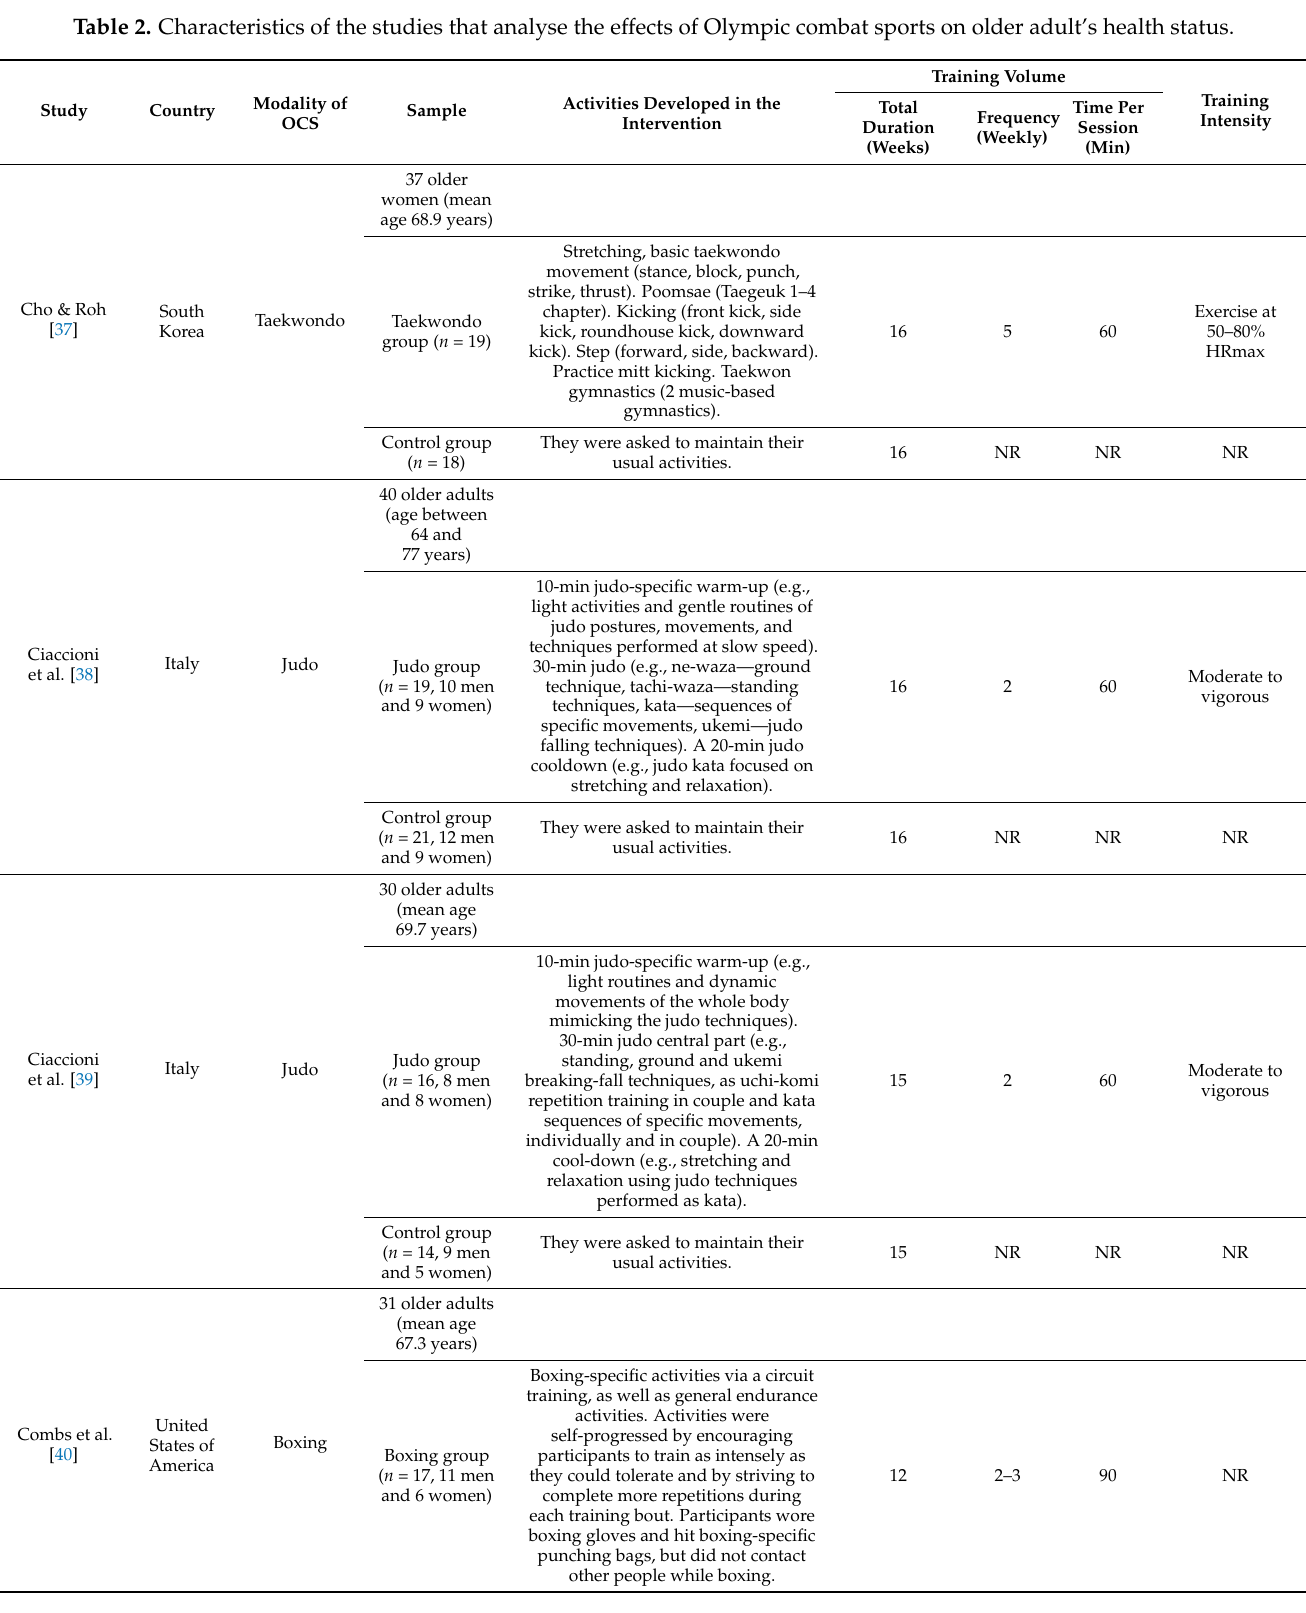
Table 2. Characteristics of the studies that analyse the effects of Olympic combat sports on older adult’s health status.